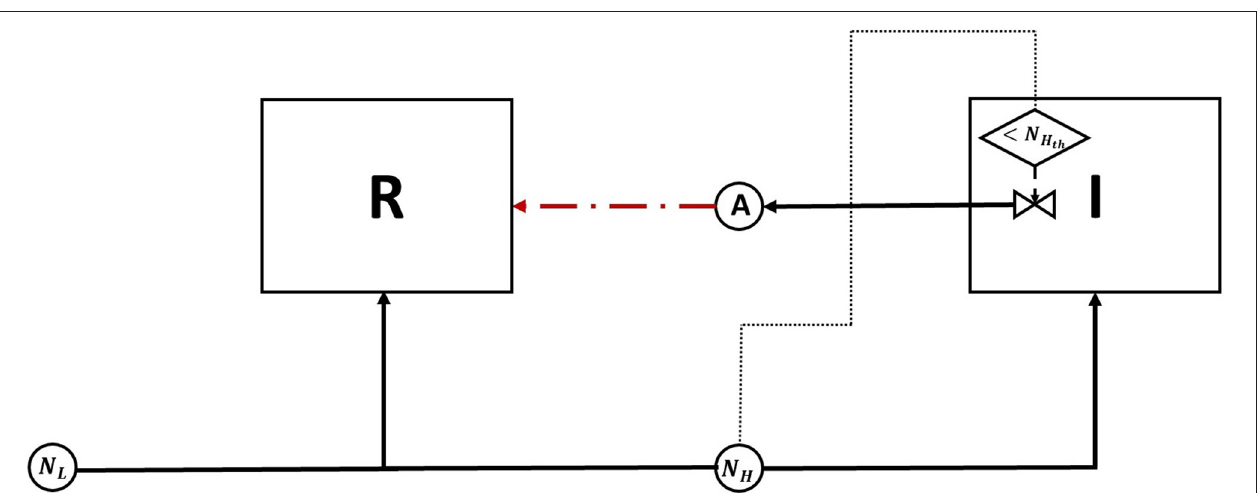
FIGURE 4 | The fitness of the two species in no antibiotic signaling scenario vs. signaling scenario. Again signaling would be expected to be evolutionary stable here as it achieves a gain in fitness for both the sender and receiver. The asterisks represent the mean of the results of 50 simulations, while the error bars represent the standard deviation of the results.